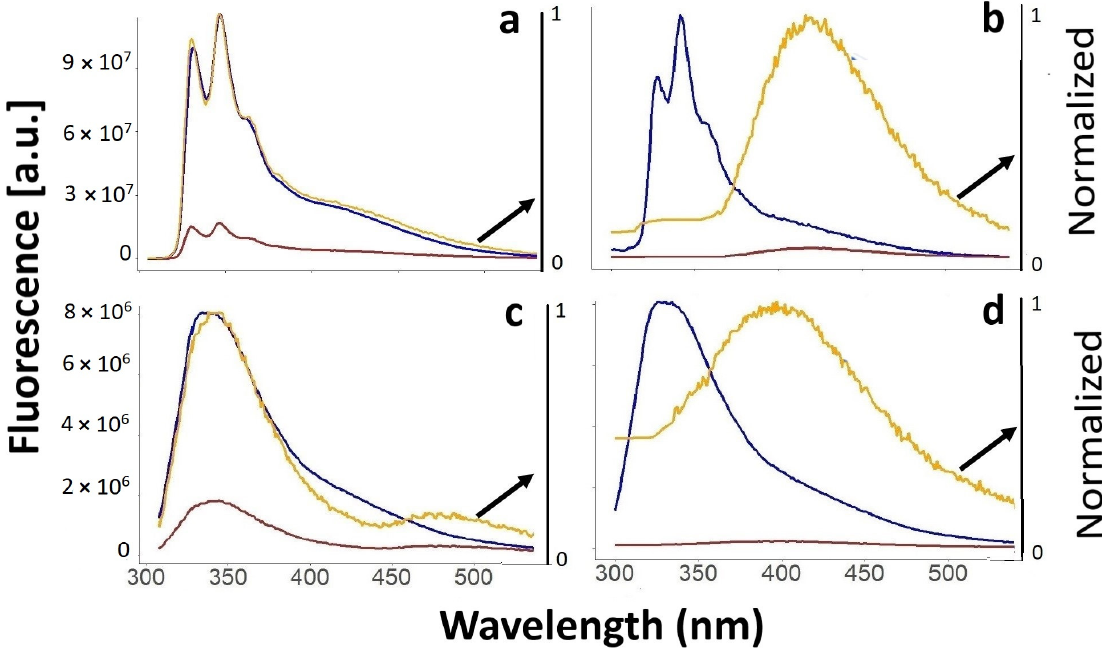
Figure 2. Emission spectra of 1,8-DHN ( a ) and 1,8-DHN with 5% H 2 O 2 ( b ), 5,6-DHI ( c ), and 5,6-DHI with 5% H 2 O 2 ( d ), (Blue): untreated; (Brown): after UV irradiation and 4 or 10 days of storage for 5,6-DHI and 1,8-DHN, respectively. (Light orange) normalized intensity for aged samples to compare peak shapes (normalized version of brown-colored spectra, marked by the black arrows). All samples were diluted in water by 1:20. For 1,8-DHN λ ex = 302 nm, for 5,6-DHI λ ex = 298 nm. Original 1,8-DHN solution: pH = 6.0, original 5,6-DHI solution: pH = 6.5, aged 1,8-DHN: pH = 7.0, aged 5,6-DHI: pH = 7.0.